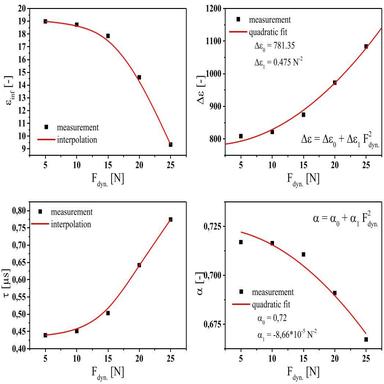
Dynamic load dependence of the Cole-Cole fit parameters (εinf, Δε, τ, α) of the SBR sample.